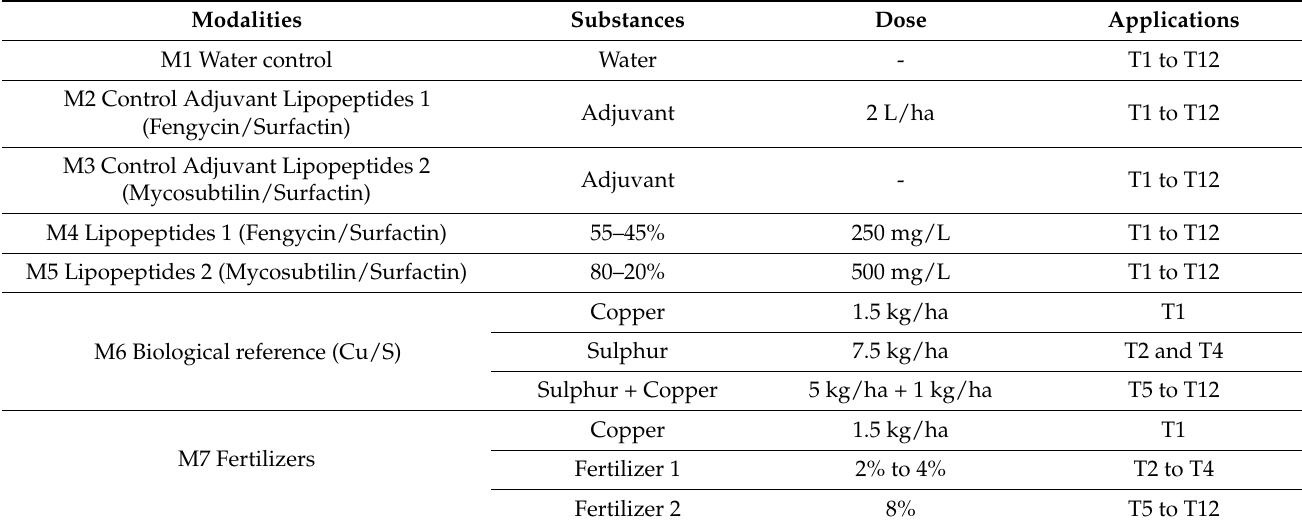
Table 3. Summary of the modalities studied against apple scab in